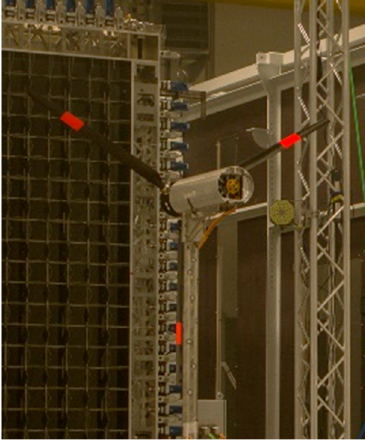
Figure 3. Prepared MoWiTO with red foil.